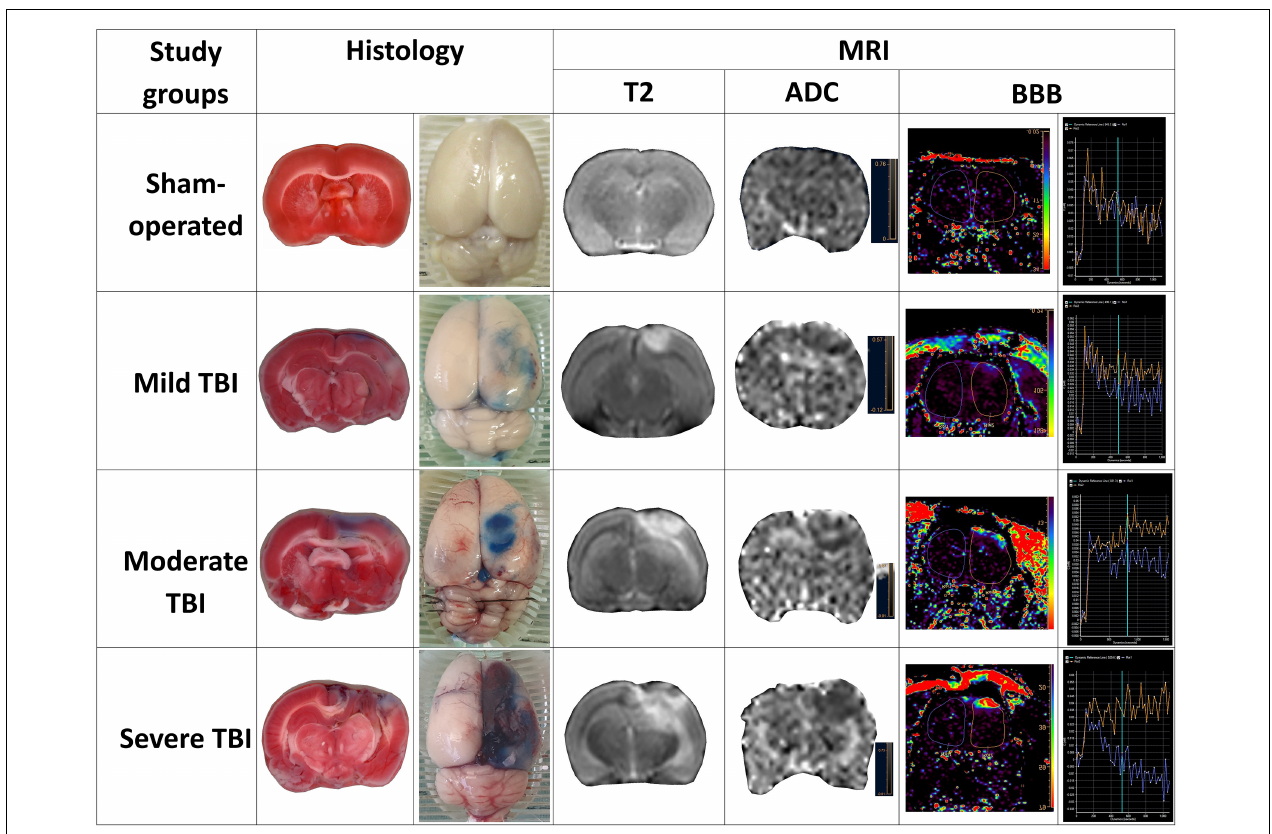
FIGURE 5 | Representative sample of parameters of severity outcome following TBI by histological and MRI-determined techniques in the various experimental